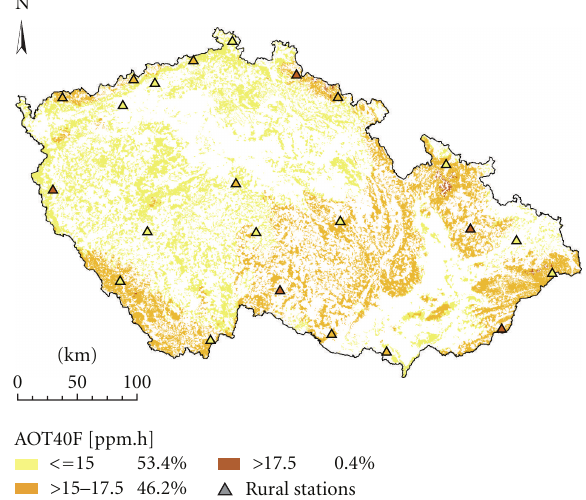
Figure 5: Spatial interpolation of exposure index AOT40F for the 2008 vegetation season (ppb.h), interpolation technique ALR + res OK, grid resolution 1 × 1 km, forested